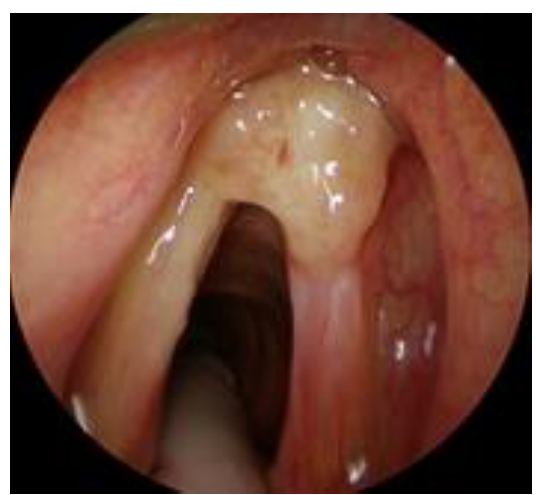
Figure 2. T1b without AC involvement.